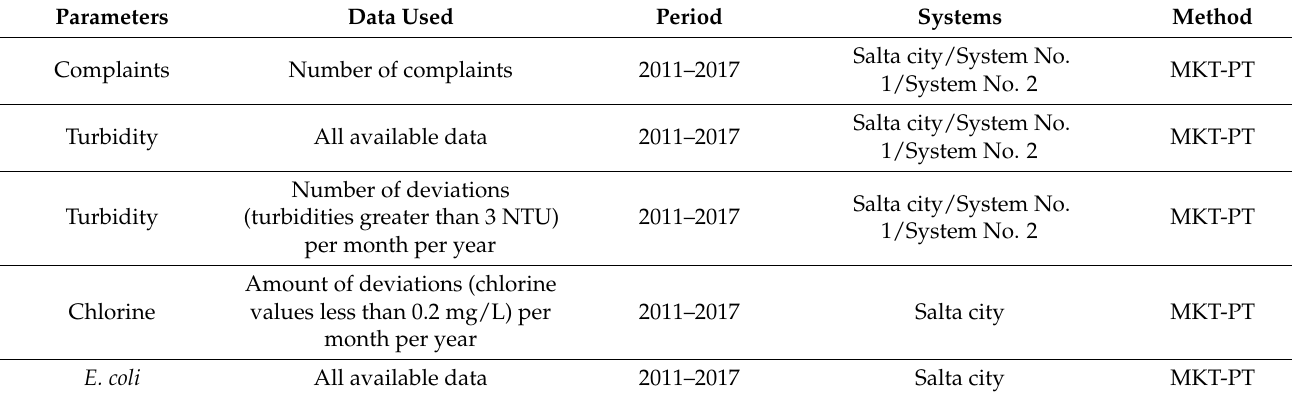
Table 1. Variables and data analysis methods used in this